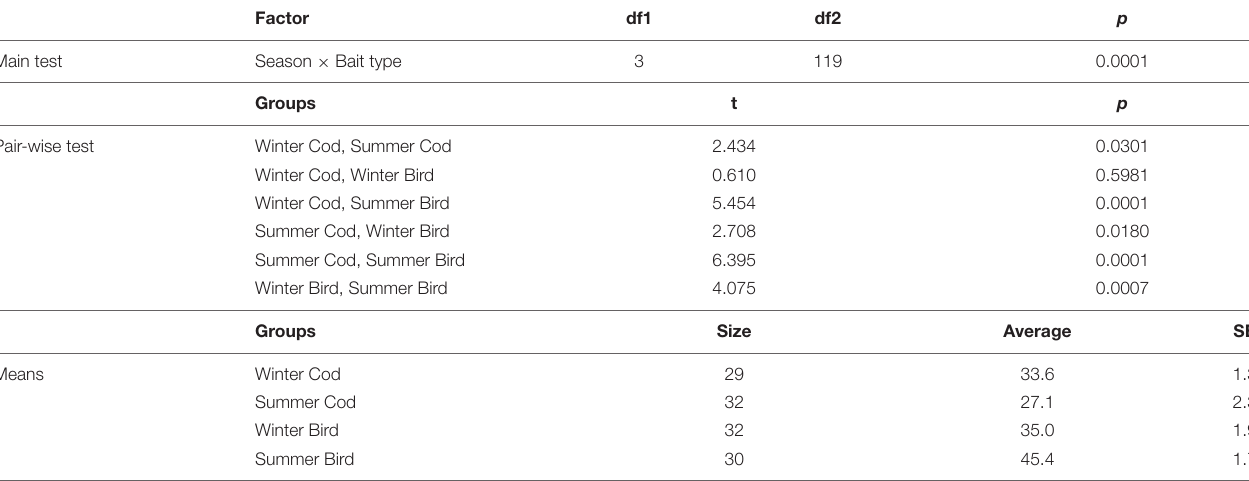
TABLE 4 | Results of PERMDISP analyses comparing temporal variation in scavenger assemblage structure across four groups (combinations of Season × Bait type). Factor df1 df2